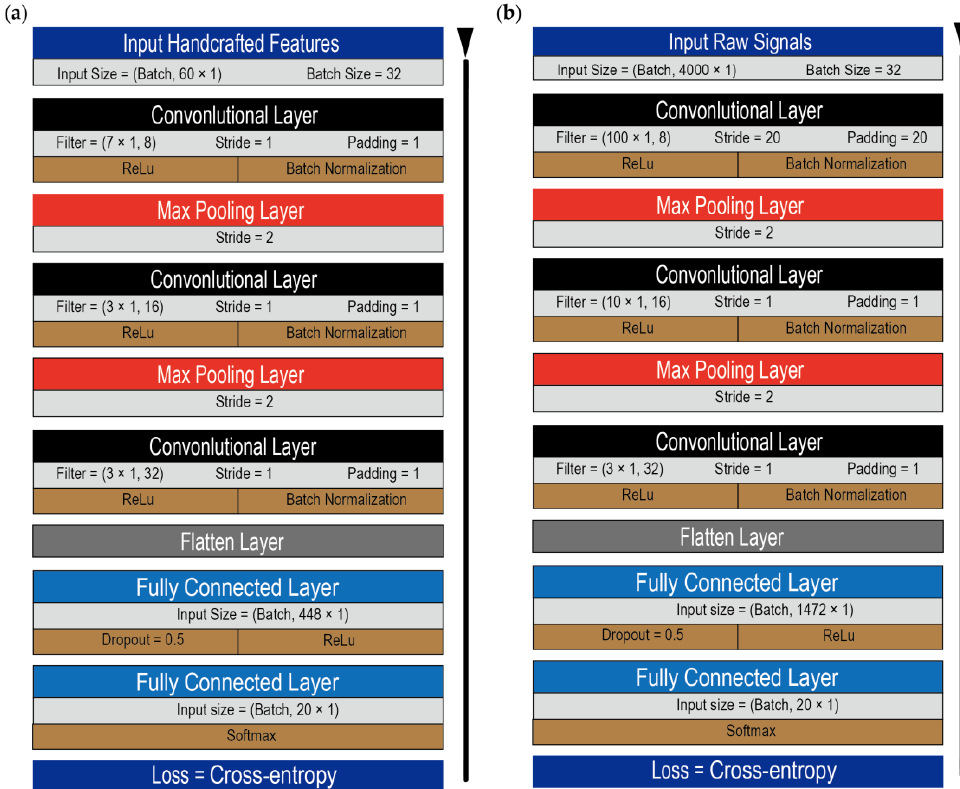
Figure 5. The architectures and layer configurations for the reference convolutional neural networks: ( a ) Handcrafted features as input; ( b ) Raw signals as input. Table 4 . The performance of convolutional neural networks with handcrafted features as input. These convolutional neural networks are variants of the reference model presented in Figure 5a.